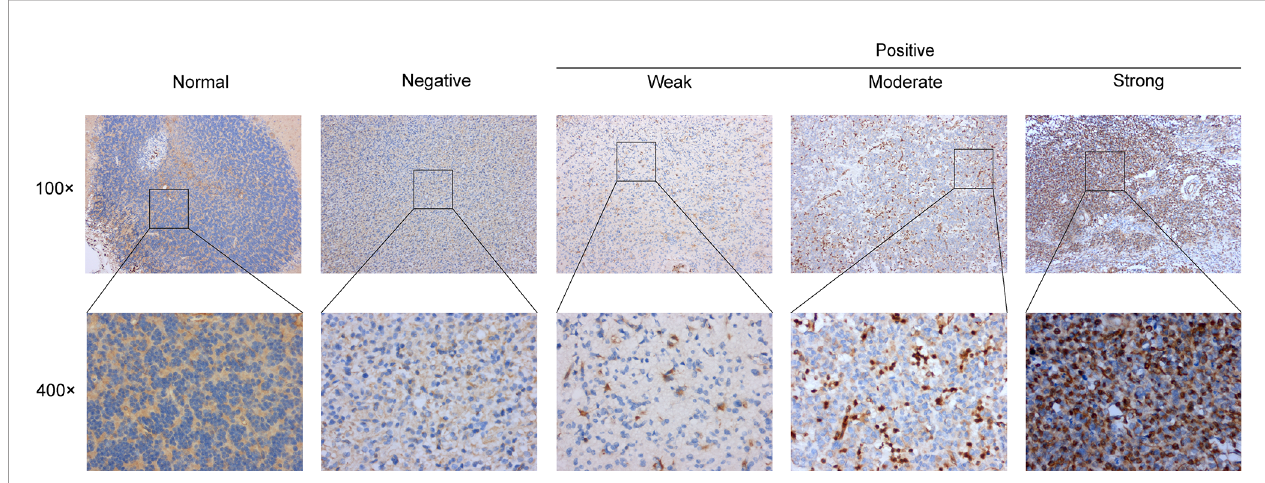
FIGURE 2 | Representative images of immunohistochemical (IHC) staining of PD-L2 protein in glioma tissues and normal brain tissue (×100 and ×400).